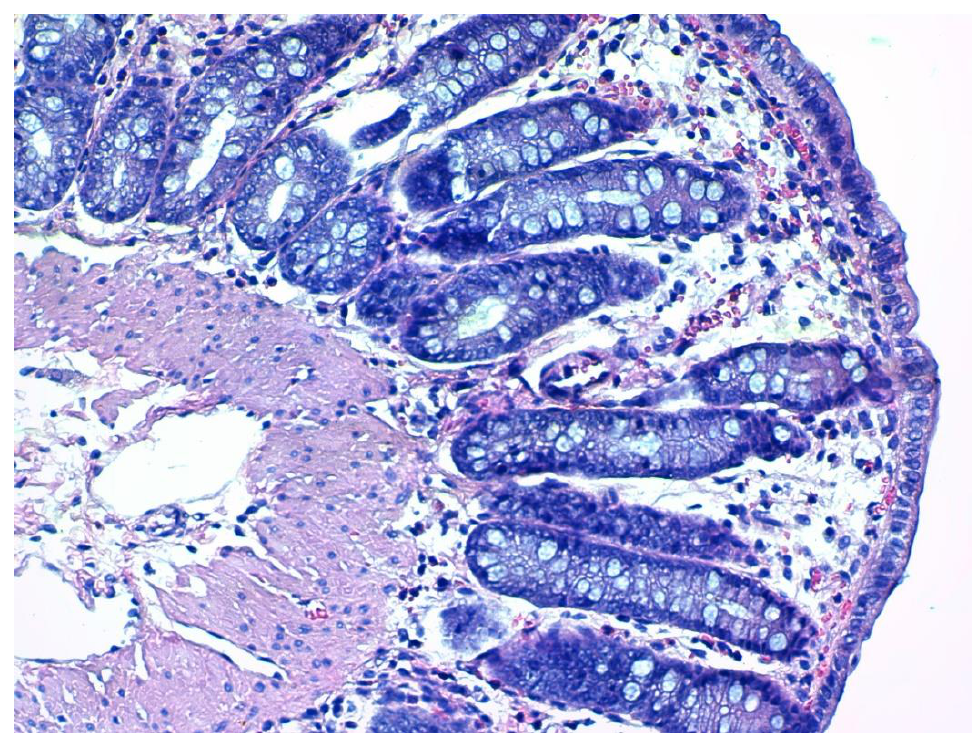
Figure 6. Colon histology of rats with active colitis (AA group). Colon tissue of rats 24 h after colonic exposure to AA demonstrates inflammatory infiltrates in the mucosa and submucosa, moderate levels